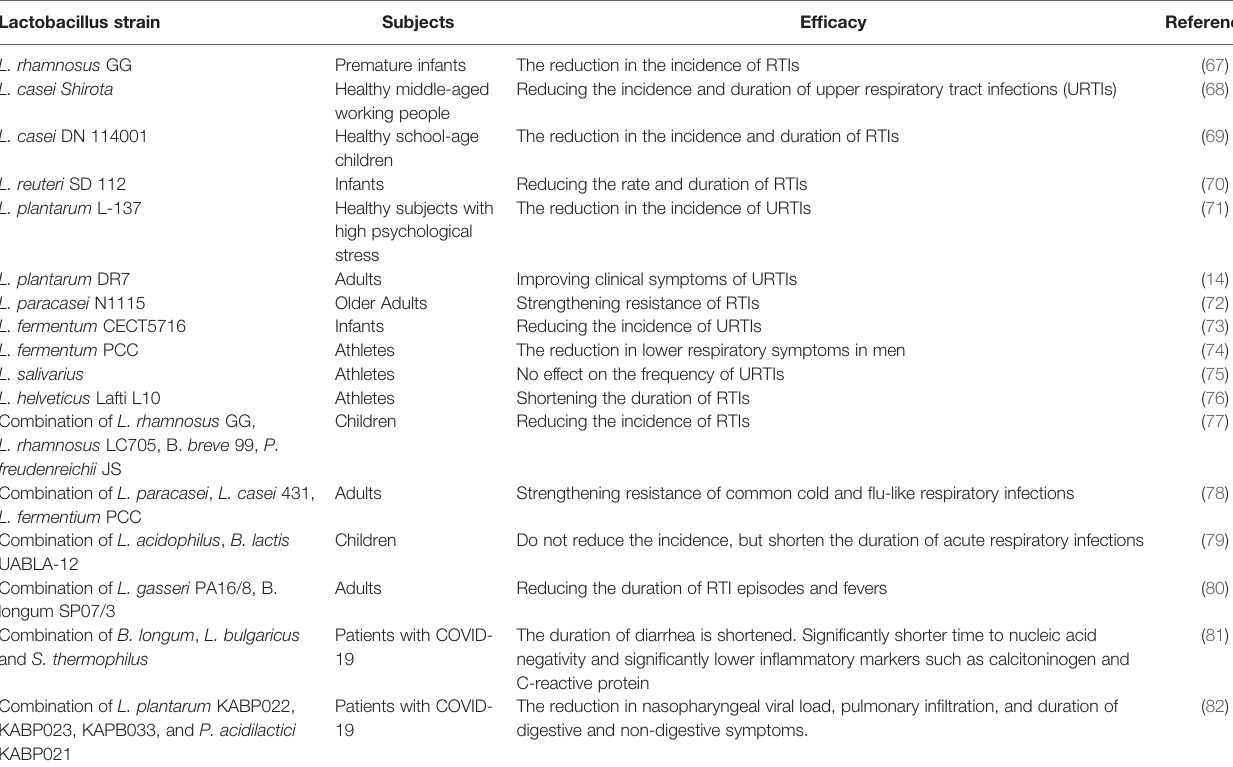
TABLE 2 | Treatment effect of clinical trials regarding the application of Lactobacillus in improving symptoms of respiratory tract infections (RTIs). Lactobacillus